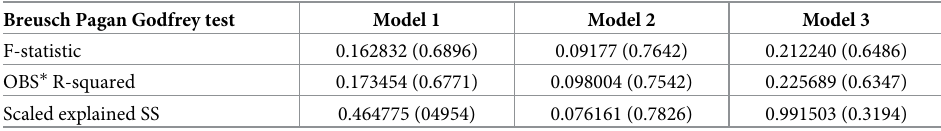
Table 4. Implementation of the residual heterogeneity test, 1991–2020, Taiwan.